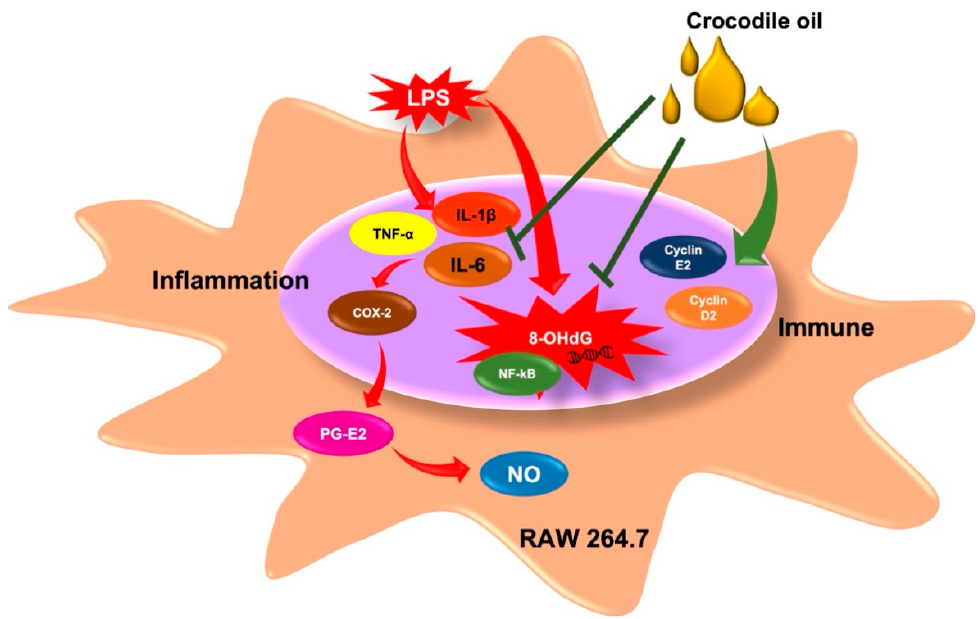
Figure 7. Inhibitory effects of CO on inflammatory status and its mechanisms.